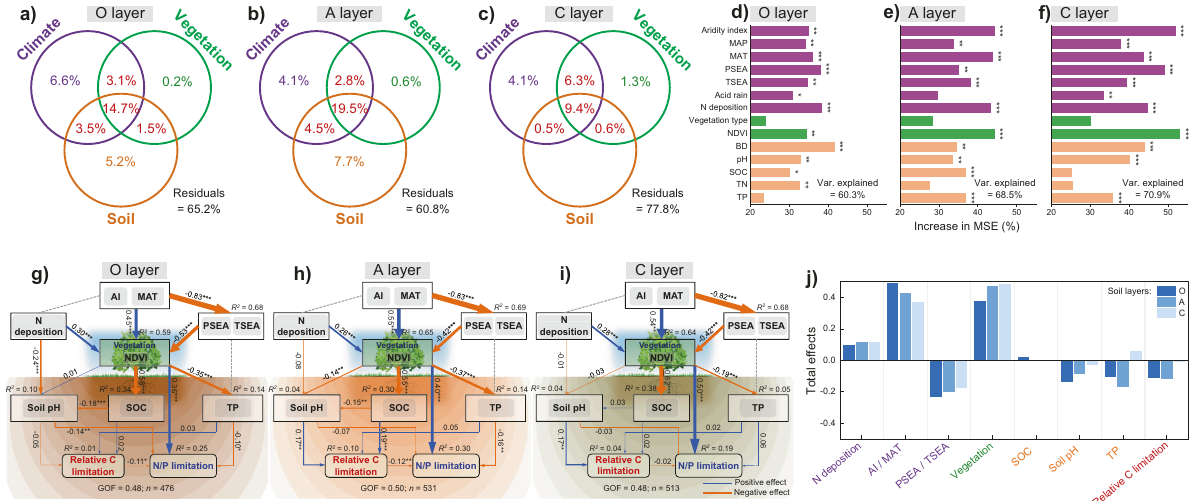
Fig. 3 Driving factors of soil microbial N/P limitation across Chinese forests. a – c Variation partitioning analysis showing the effects of environmental drivers (climate, vegetation and soil) on microbial N/P limitation in different soil layers. Soil layers: O, organic horizon; A, eluvial horizon; C, parent material horizon. Climate includes aridity index (AI), mean annual precipitation (MAP), mean annual temperature (MAT), precipitation seasonality (PSEA), temperature seasonality (TSEA), acid rain (pH) (Acid rain), total N deposition (N deposition). Vegetation includes vegetation type and vegetation index (NDVI). Soil includes soil bulk density (BD), soil pH (pH), soil organic C (SOC), soil total N (TN), soil total P (TP). d – f Random-forest models identifying the contributions of each predictor variable in explaining microbial N/P limitation in different soil layers. MSE, mean squared error. * represents signi fi cant effects at P < 0.05, ** represents signi fi cant effects at P < 0.01, *** represents signi fi cant effects at P < 0.001. g – j Partial least squares path modeling disentangling major pathways of the in fl uences of climate, vegetation, and soil properties on microbial N/P limitation in different soil layers ( g – i ), and the total effects of these variables on microbial N/P limitations ( j ). Blue and yellow arrows indicate positive and negative fl ows of causality, respectively. Numbers on the arrow indicate signi fi cant standardized path coef fi cients. R 2 indicates the variance of dependent variable explained by the models. * represents signi fi cant effects at P < 0.05; ** represents signi fi cant effects at P < 0.01; *** represents signi fi cant effects at P < 0.001.